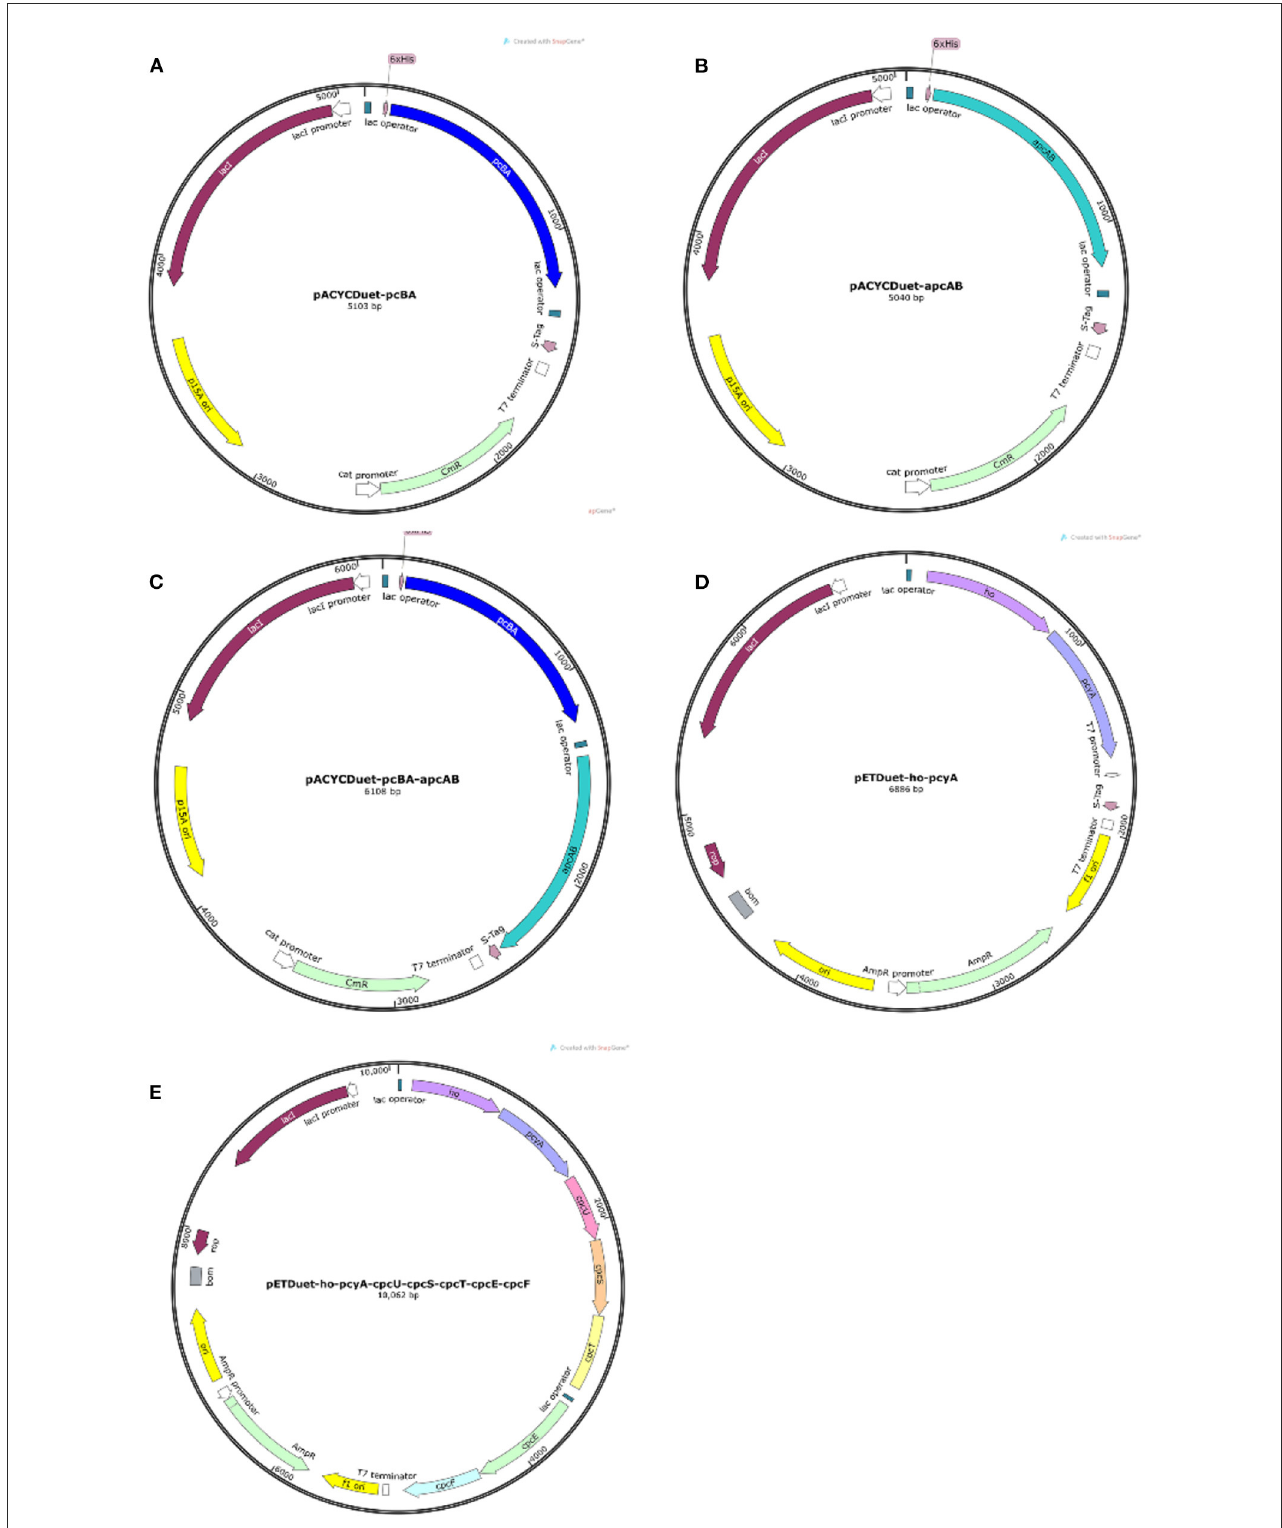
FIGURE1 Plasmid map. (A) The plasmid pACYCDuet- pcBA ; (B) the plasmids pACYCDuet- apcAB ; (C) the plasmid pACYCDuet- pcBA - apcAB ; (D) the plasmid pETDuet- ho - pcyA ; (E) the plasmid pETDuet- ho - pcyA - cpcU - cpcS - cpcT - cpcE - cpcF .